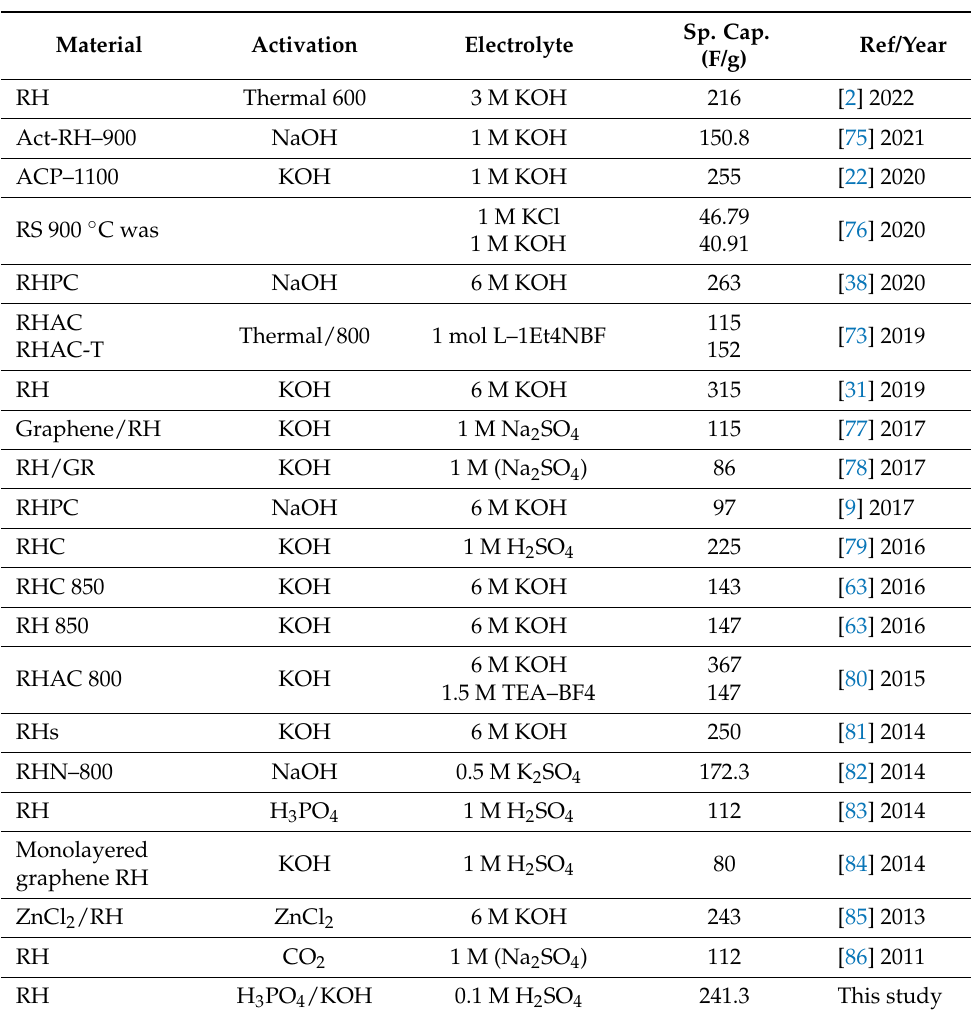
Table 1. Specific capacitance of activated carbons prepared from rice husk using different activation strategies. Material Activation Electrolyte